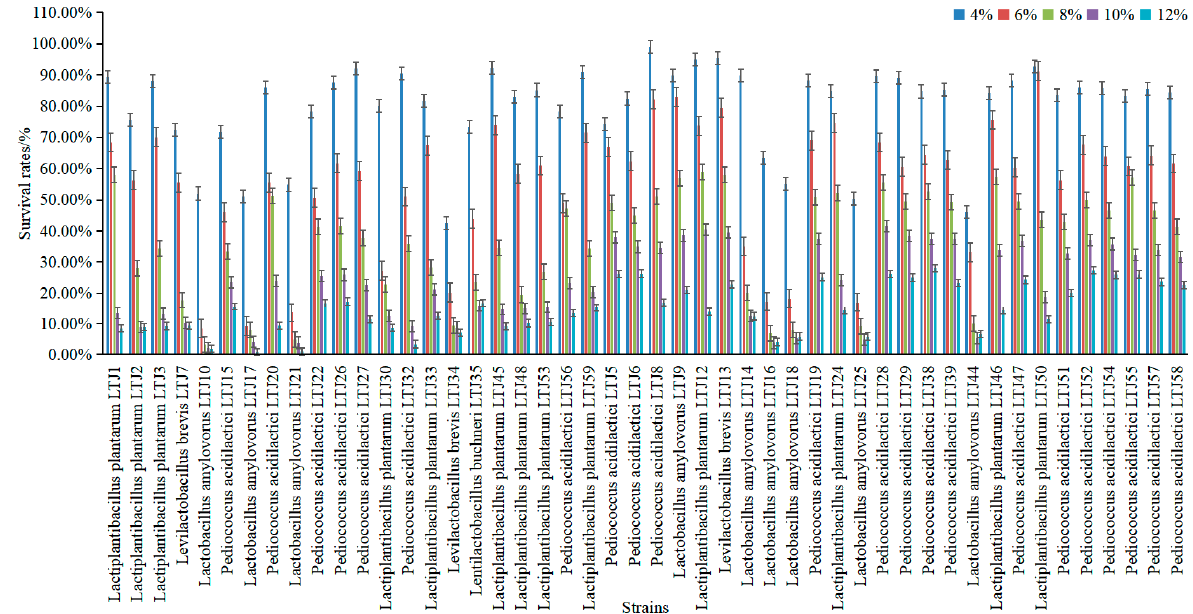
Figure 4. Effect of stress on the survival rates of strains during treatments with different concentrations of ethanol.